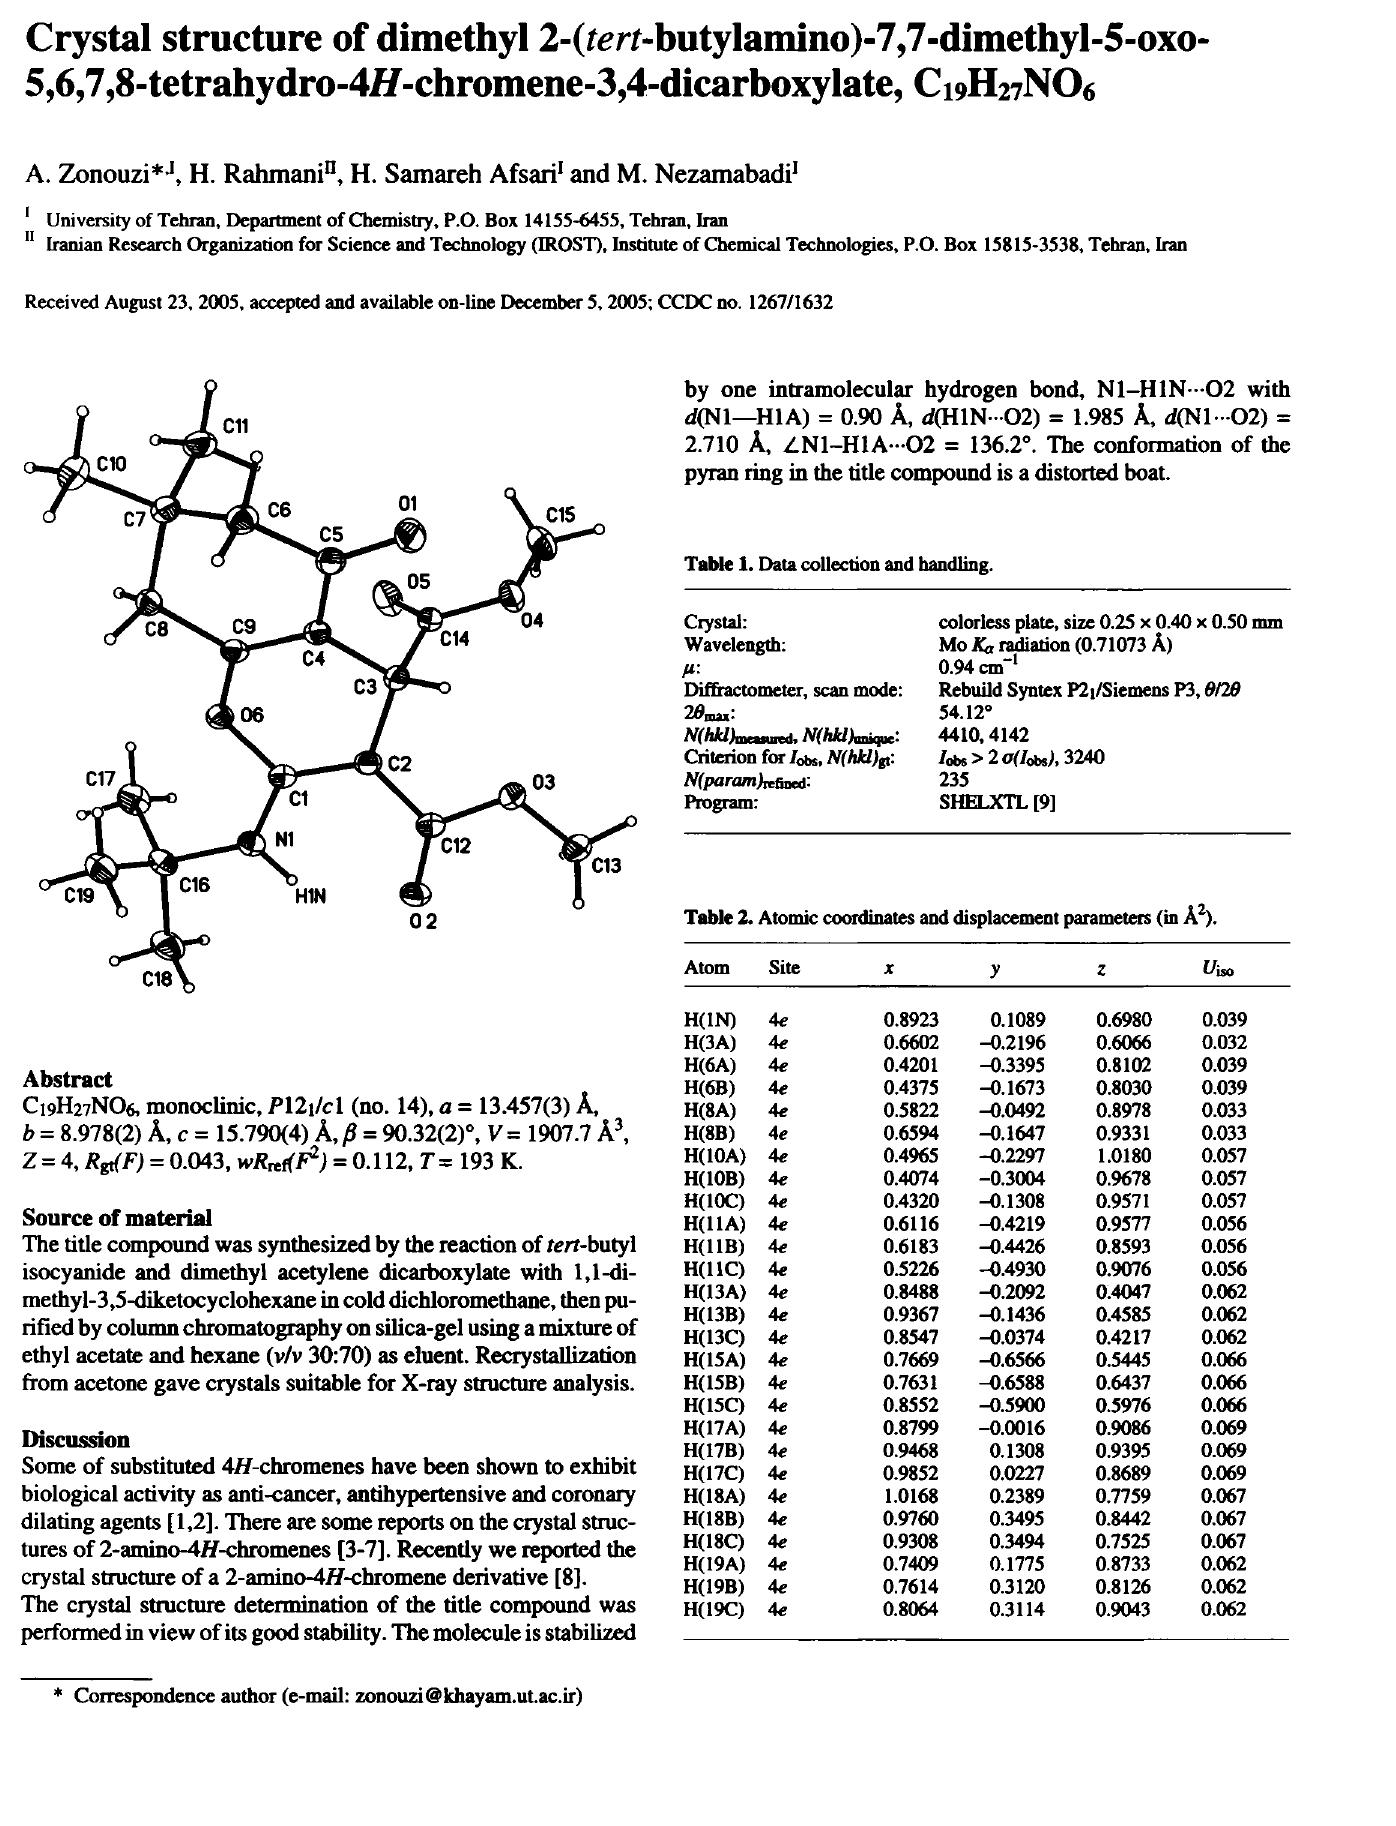
Table 1. Data collection and handling.